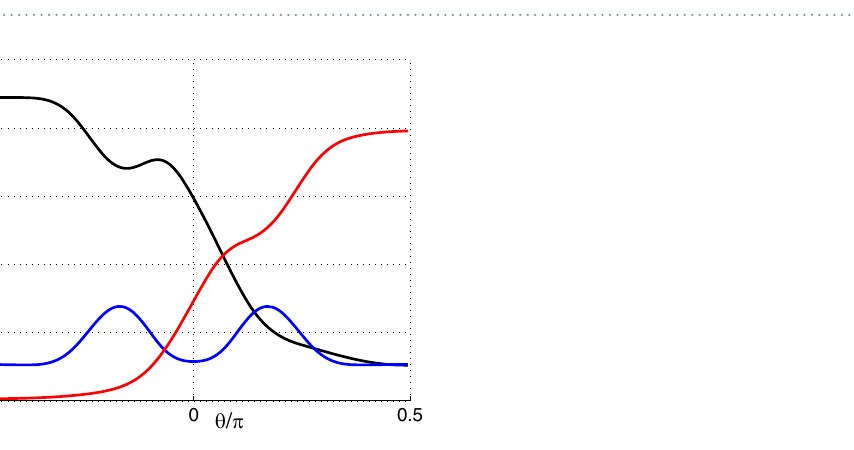
Figure 3. Real and imaginary parts of k 1 and k 2 , normalized to the wavenumber in vacuum k 0 , versus frequency in the vicinity of the ⊥  - resonance.